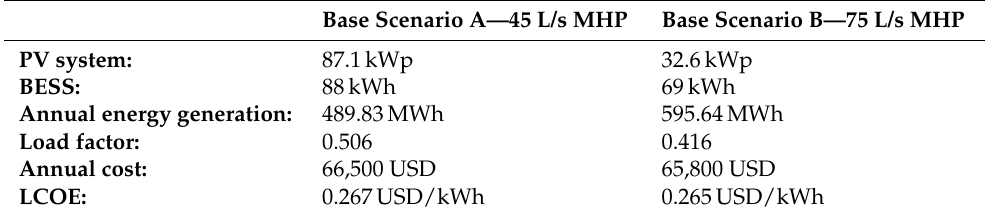
Figure 14. Weekly average load profile of HOMER (red) together with results of the scheduling approach. Table 9. Results of the microgrid optimization with HOMER